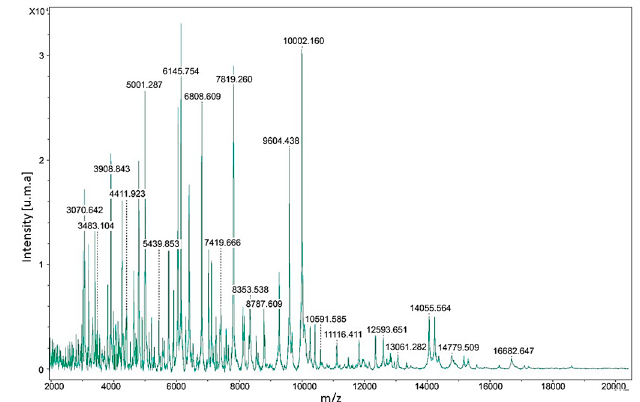
Figure 2. Reference spectrum of N. dimidiatum . On the X axis, protein mass (Dalton), and on Y, intensity units of atomic mass (u.m.a) are indicated. Numbers on peaks indicate protein mass.